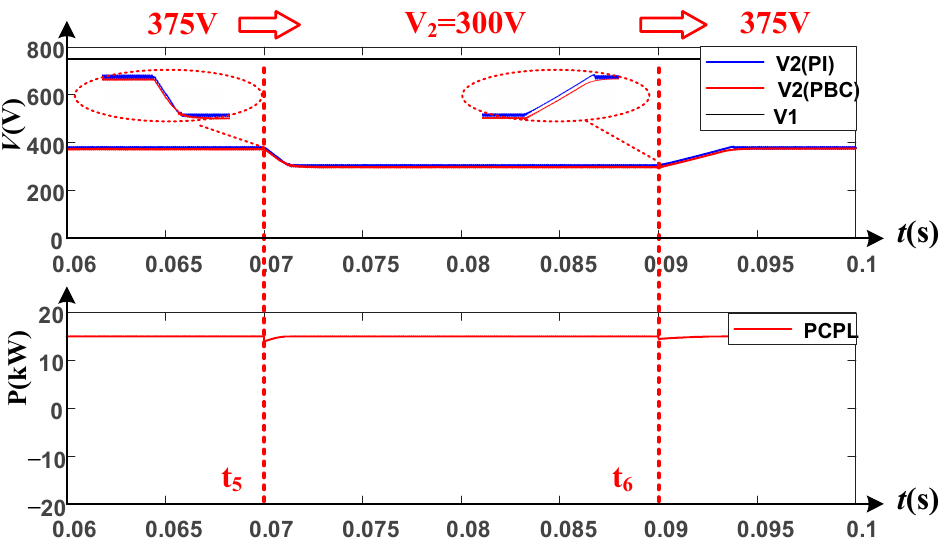
Figure 6. Waveforms in reference step simulation.